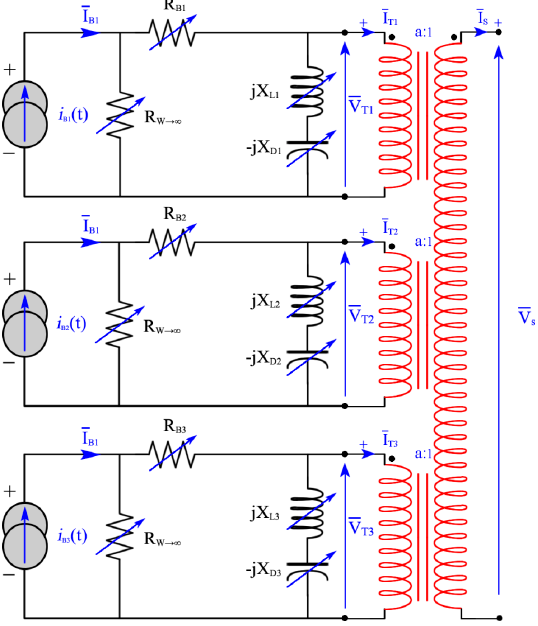
Figure 12. Equivalent electric diagram for a three ‐ blade DT ‐ VAWT.